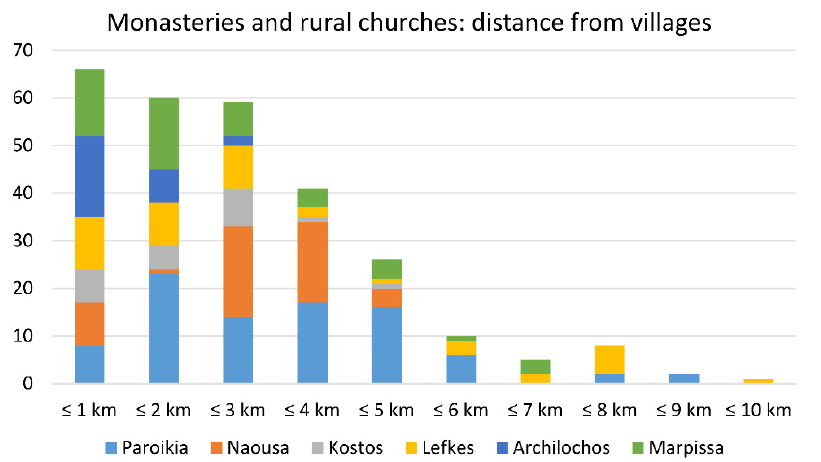
Figure 8. The distances between monastic and rural churches and their nearest settlement on the island of Paros. The community of Archilochos refers to the two neighbouring settlements of Marmara and Prodromos (data and graph by the author).